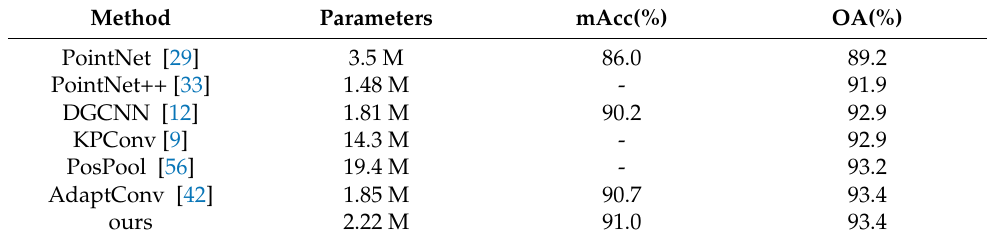
Table 6. The number of parameters and overall accuracy of different